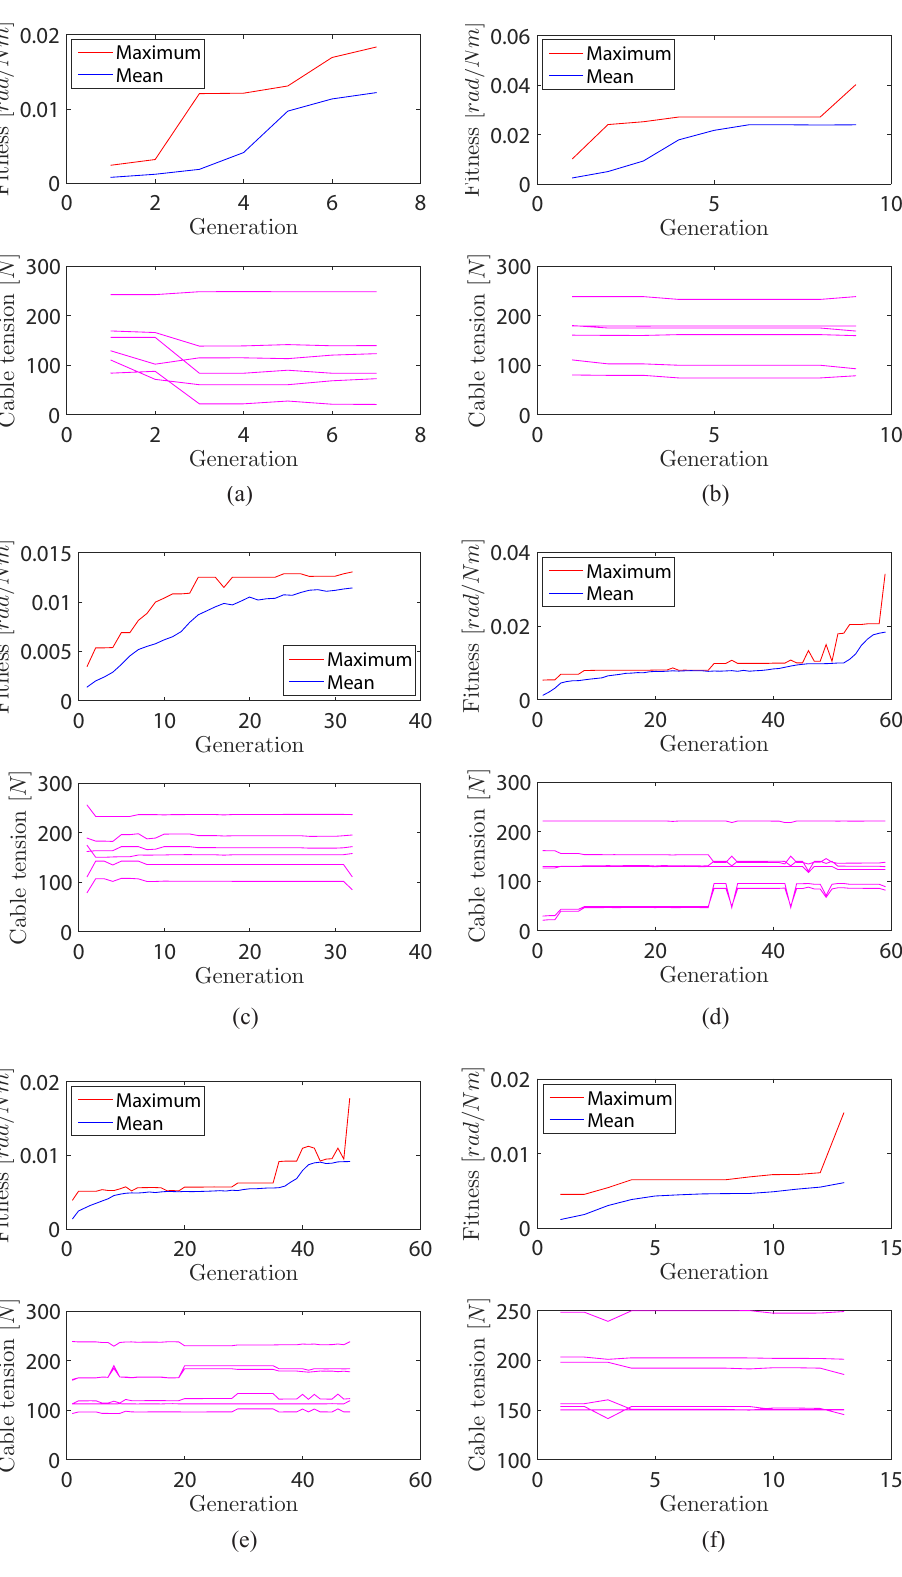
Figure 6. Iteration curves of the proposed method for the six sub-cases: ( a ) Case 1a, ( b ) Case 1b, ( c ) Case 1c, ( d ) Case 2a, ( e ) Case 2b, ( f ) Case